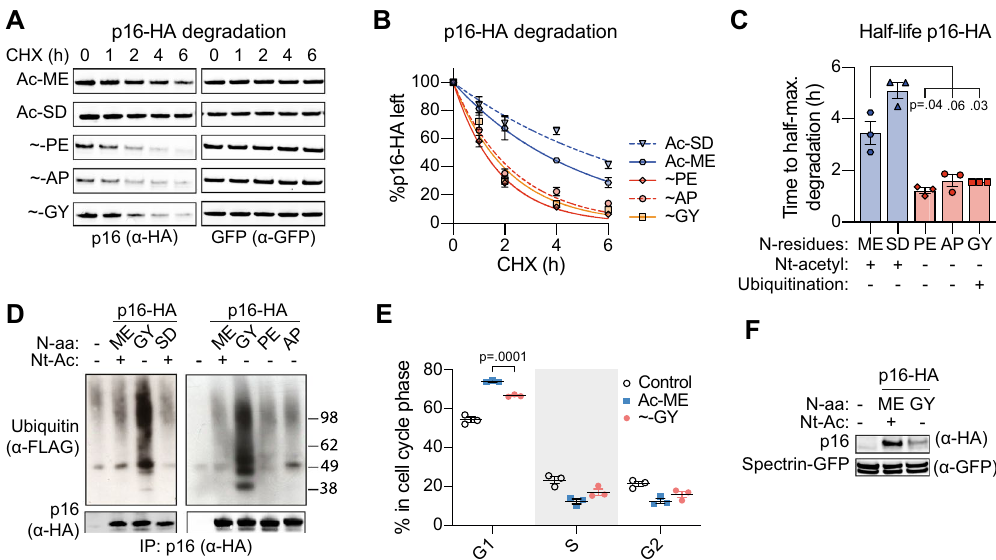
Figure 4. Nt-acetylation correlates with stability of the naturally lysineless protein p16. ( A , B ) HEK 293T cells were transfected to express GFP as a reference protein, together with p16-HA variants carrying indicated N-terminal dipeptide sequences (”Ac-” = Nt-acetylated, “ ~ ” = Nt-acetyl-free). Cells were cultured in presence of CHX (50 μg/ml) for the indicated time periods, followed by immunoblot analysis with antibodies to the HA tag and to GFP. P16-HA signals were quantified and corrected for GFP signal intensity, and the resulting value at the 0 h time point was set to 100%. Data points were connected by a one-phase decay curve fit. Panel A shows a representative Western blot image, panel B shows the quantification (n = 3; mean ± SEM). ( C ) Based on the data in panel B, the half-lives of the indicated p16-HA variants were determined (n = 3; mean ± SEM, Ratio paired t-test, two-tailed). ( D ) HEK 293T cells were transfected to express indicated p16-HA variants and FLAG-tagged ubiquitin, followed by lysis under denaturing conditions. Next, p16-HA was immunoprecipitated and the precipitates were analyzed by immunoblotting. A representative image of three independent biological replicates is shown. ( E ) U-2 OS cells were transfected to express indicated p16-HA variants, followed by DNA staining with propidium iodide, and cell cycle analysis by flow cytometry (n = 3; mean ± SEM, Paired t-test, two-tailed). ( F ) Cell lysates from cells described in panel E were analyzed by immunoblotting. Spectrin-GFP is a transfection and loading control.